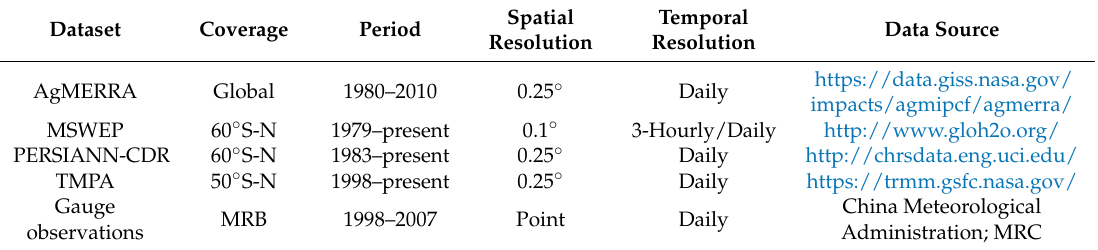
Table 1. Background information for selected global precipitation products used in this